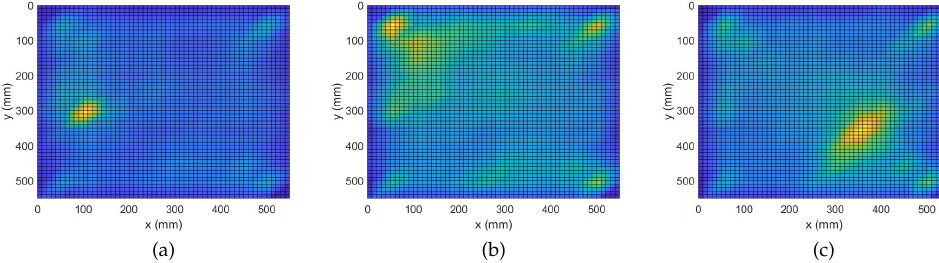
Figure 6. Damage Detection with Single Sensor MUSIC. ( a ) M 1 : 1 point-like mass. ( b ) M 4 : 4 point-like masses. ( c ) M E : 1 extended